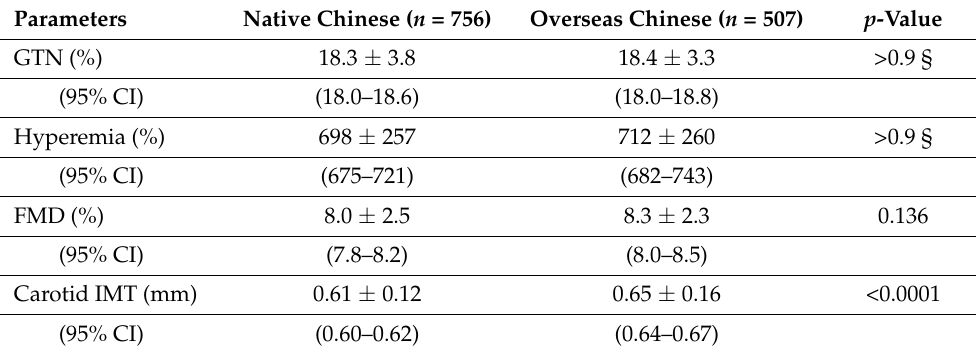
Table 5. Vascular parameters of 756 native vs. 507 overseas